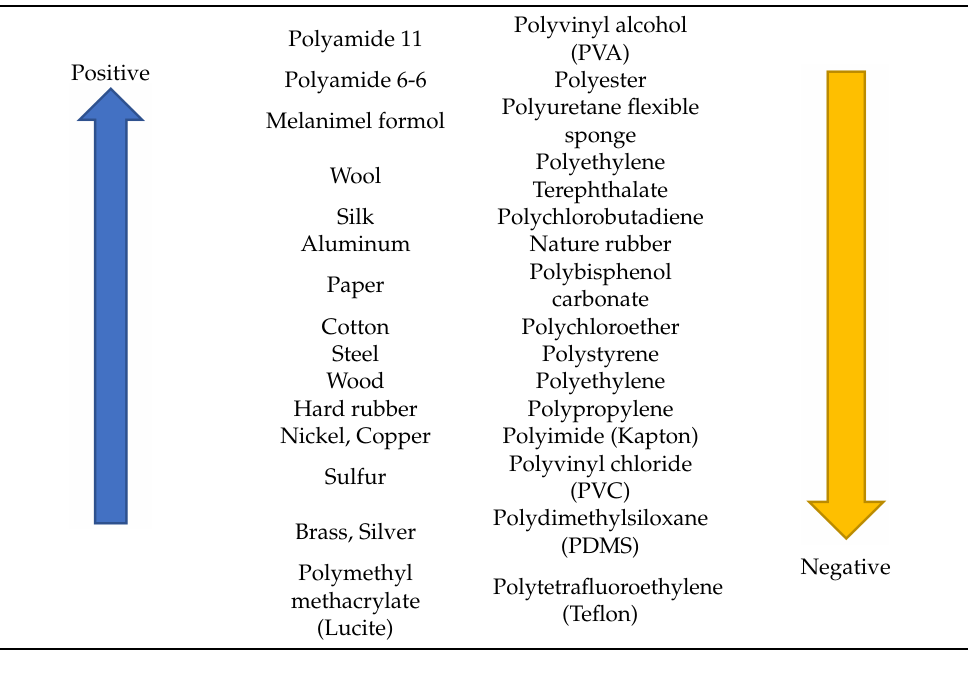
Table 1. Triboelectric tendency of materials: Triboelectric tendency series for common materials in TENG by easily losing electrons (positive) and/or getting electrons (negative).